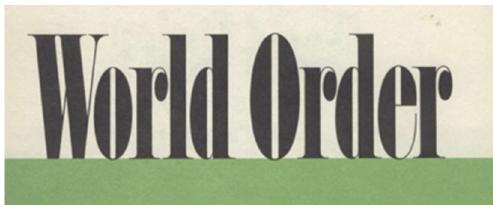
Figure 1. typeface for 1966 World Order magazine.